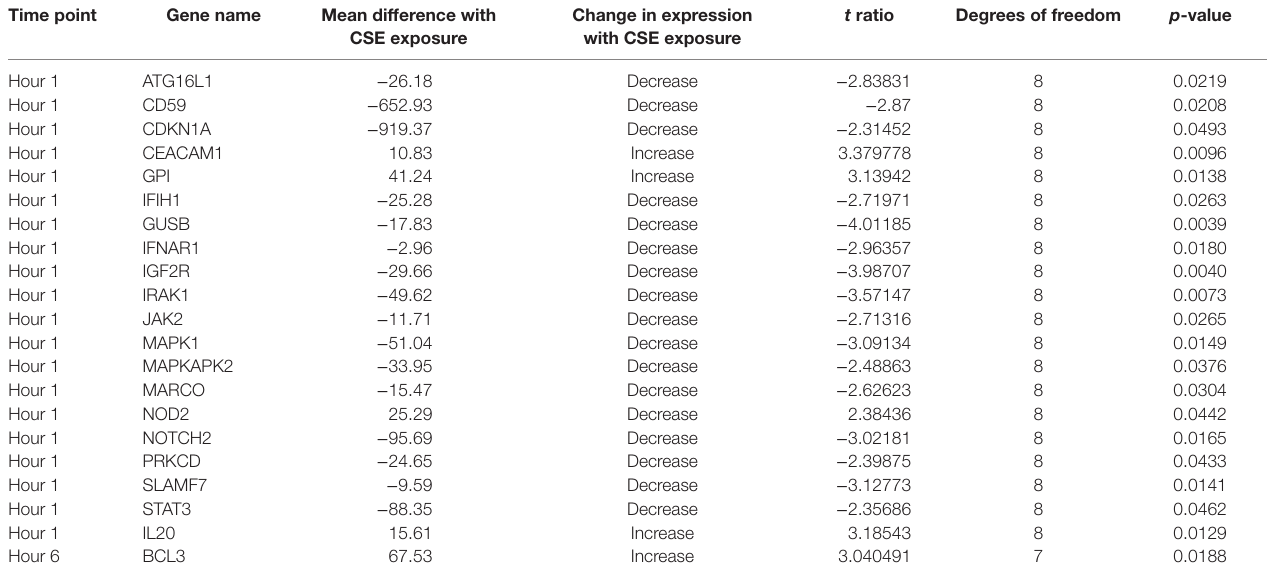
TaBle 1 | changes in gene expression in comparisons of cigarette smoke extract and unexposed treatments of lTa-stimulated Phnec from healthy individuals. Time